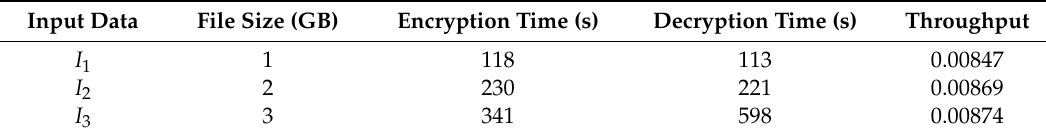
Table 1. Experimental results of execution time of encryption/decryption, throughput for BH-WABE. Input